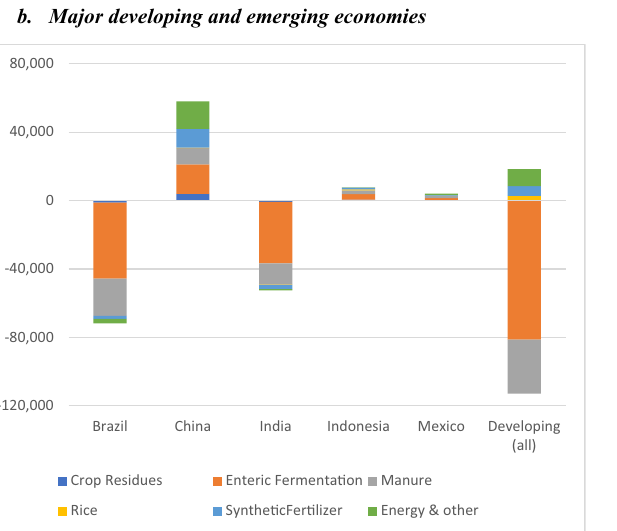
Fig. 2 Impact of current coupled subsidies and border measures on GHG emissions by commodities and selected countries and country